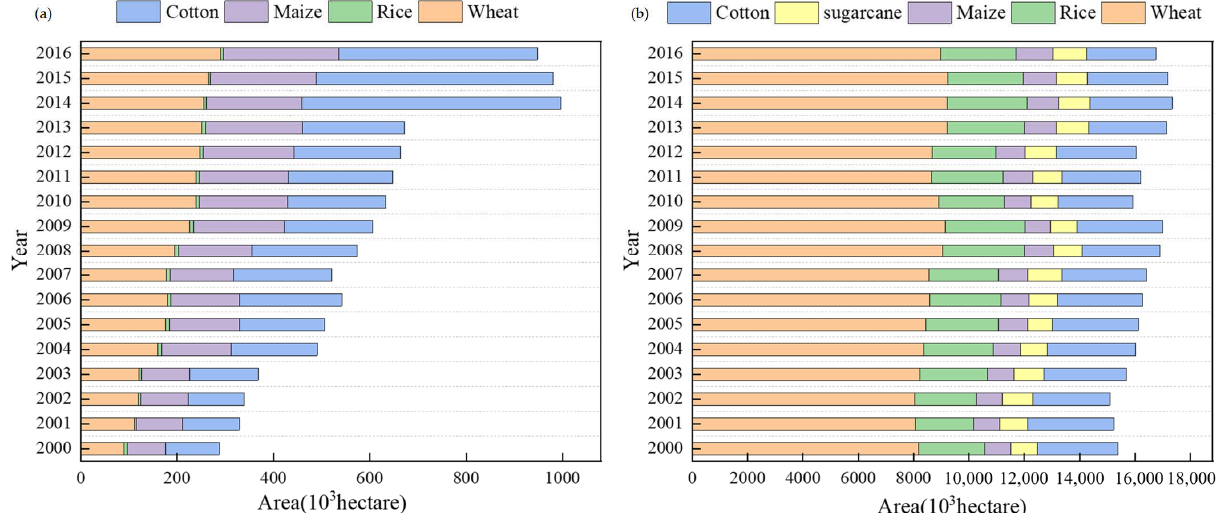
Figure 10. Change trend of crop planting structures and areas in the China–Pakistan Economic Corridor from 2000 to 2016. Note: ( a ) Xinjiang portion of the CPEC; and ( b ) Pakistan portion of the CPEC.